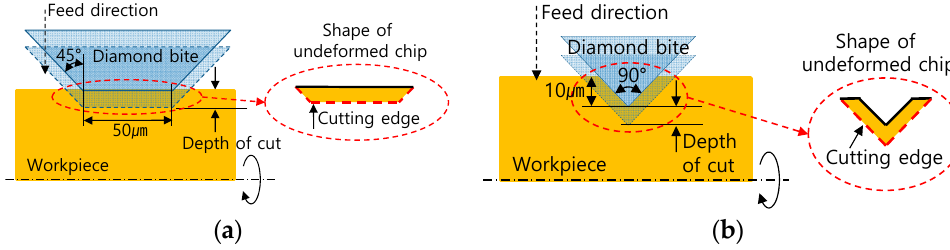
Figure 4. Cutting force measurement for the different section shapes: ( a ) trapezoidal section shape, ( b ) V-shaped sectional shape.